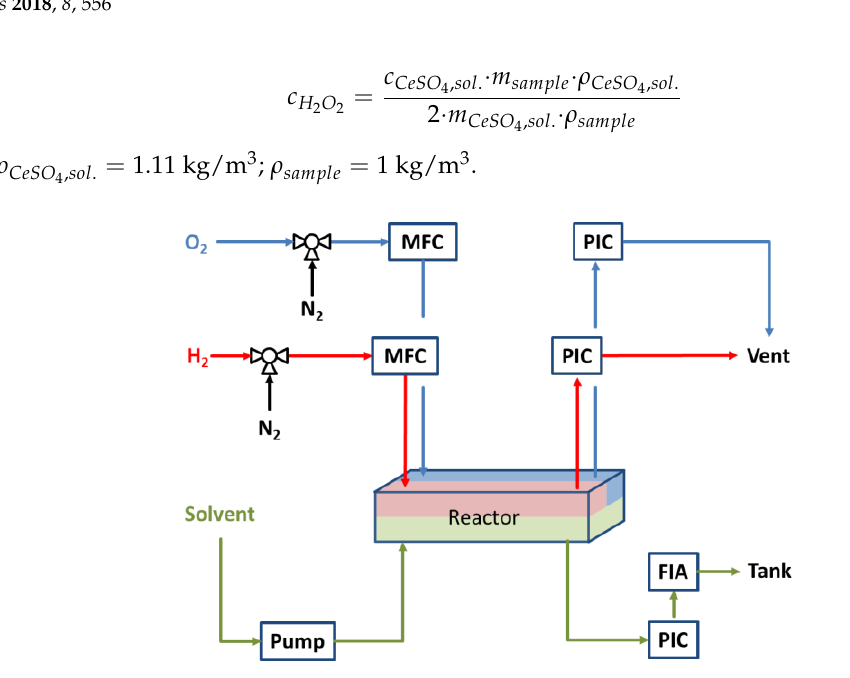
Figure 10. Overview of the experimental setup for continuous direct synthesis of H 2 O 2 with mass flow controller (MFC), pressure controller (PIC) and flow injection analysis (FIA).